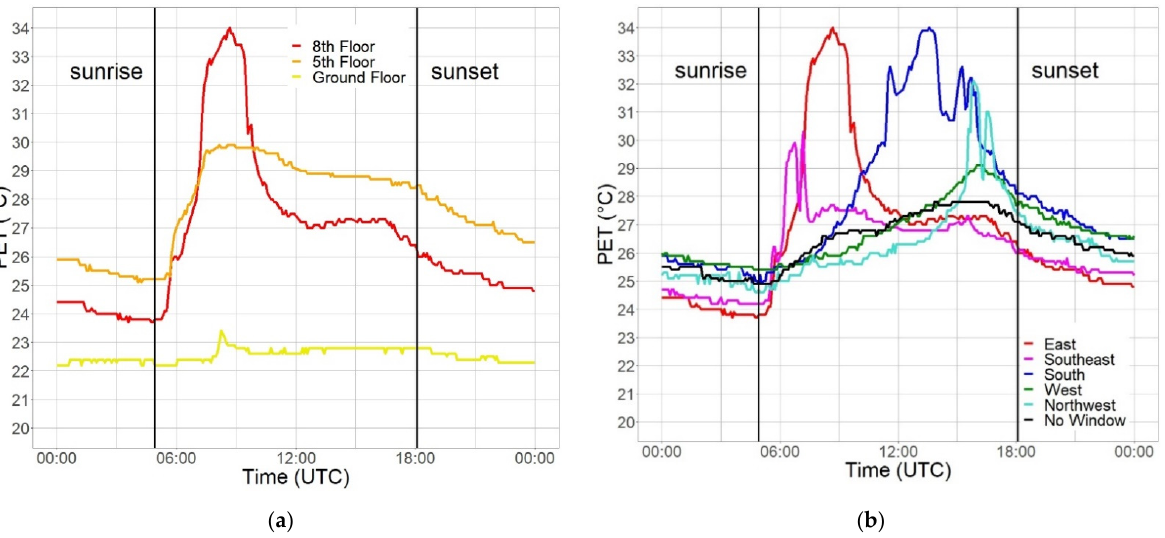
Figure 7. Physiologically equivalent temperature ( PET) (°C) measured by MoBiMets in the same office building in the city center of Freiburg on 5 September 2021: ( a ) all sensors in offices with windows exposed to the east on different floors; ( b ) on the same floor (eighth) with different window exposures.